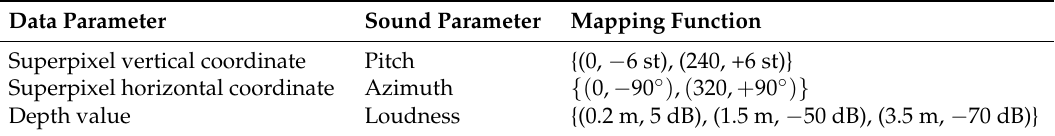
Table 1. Parameter mapping rules of image sonification. Parameters of superpixel are mapped to the parameters of sine waves. The origin of the image coordinate system is at the top left corner of raw depth images at the resolution of 320 ×